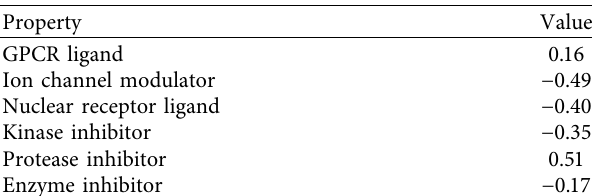
Table 6: Bioactivity scores of the alternaramide marine cyclo- pentadepsipeptide calculated for its biological target interactions.